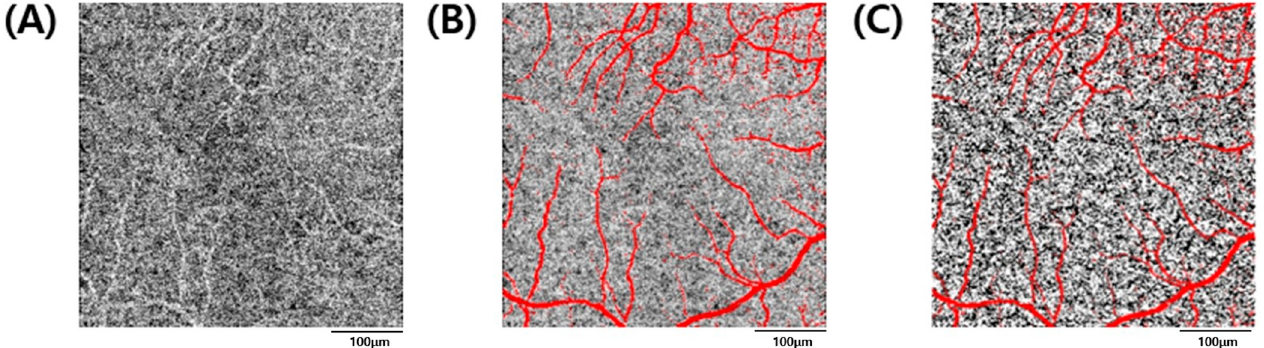
Figure 3. Measurement of the choriocapillaris flow void features. ( A ) Choriocapillaris angiogram. ( B ) Projection mask (red pixels) derived from the superficial and deep angiograms superimposed on the choriocapillaris angiogram. ( C ) Binarization of choriocapillaris layer using the “Otsu method”.